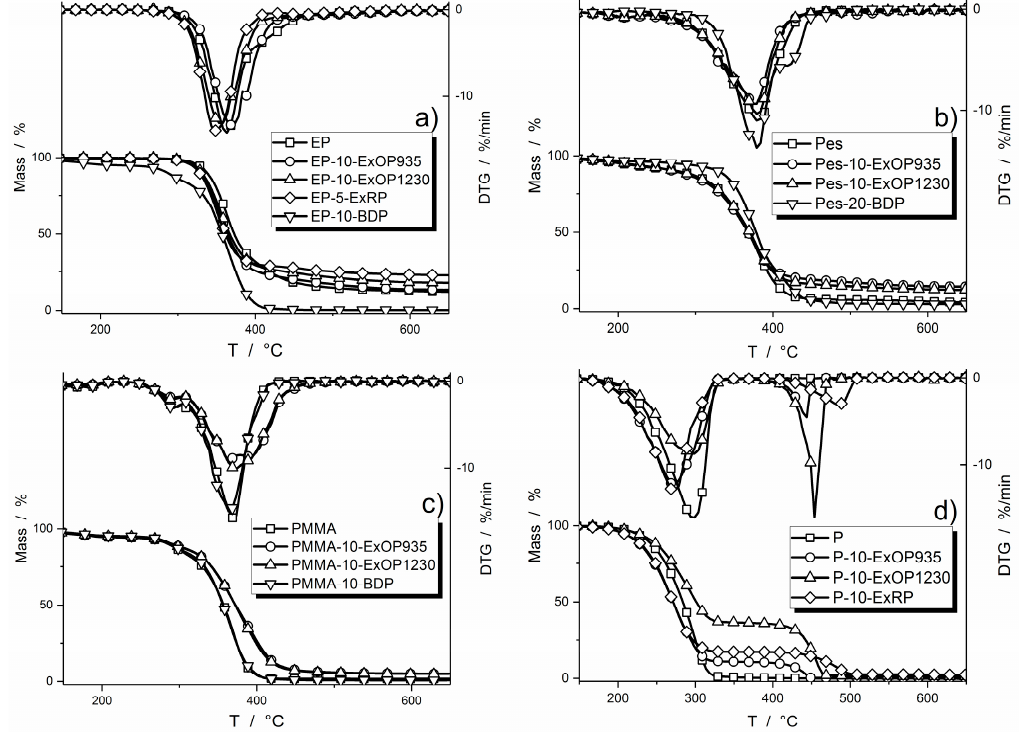
Figure 1. Thermogravimetric (TG) and derivative thermogravimetric (DTG) results for selected flame retarded and non-flame retarded specimens with: epoxy resin ( a ); polyester resin ( b ); PMMA resin ( c ); and paraffin ( d ) as polymer matrix.